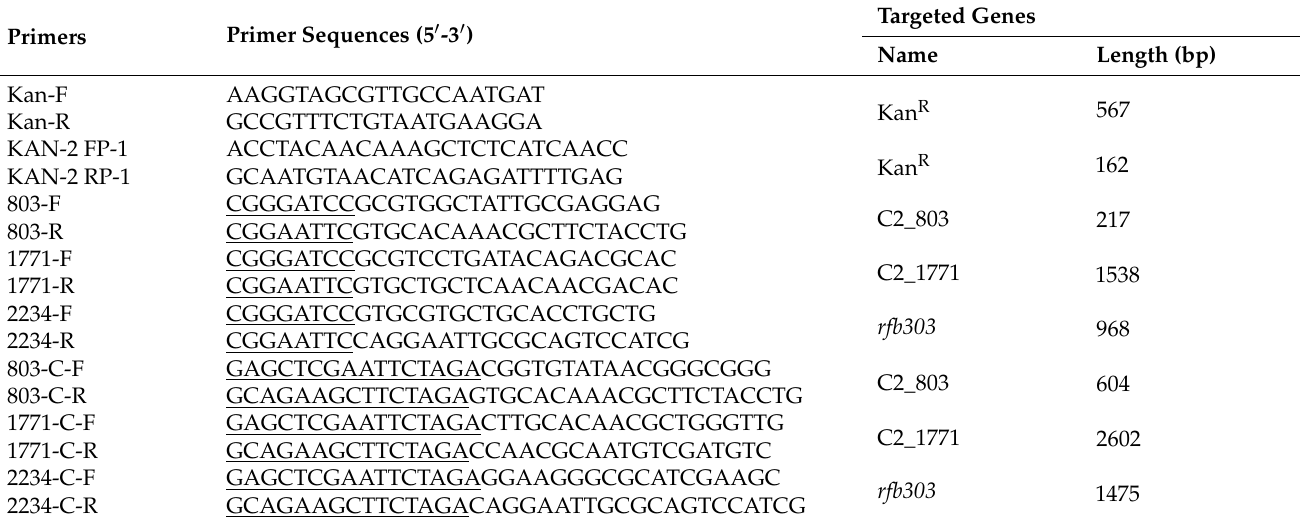
Table 3. List of primers used in this